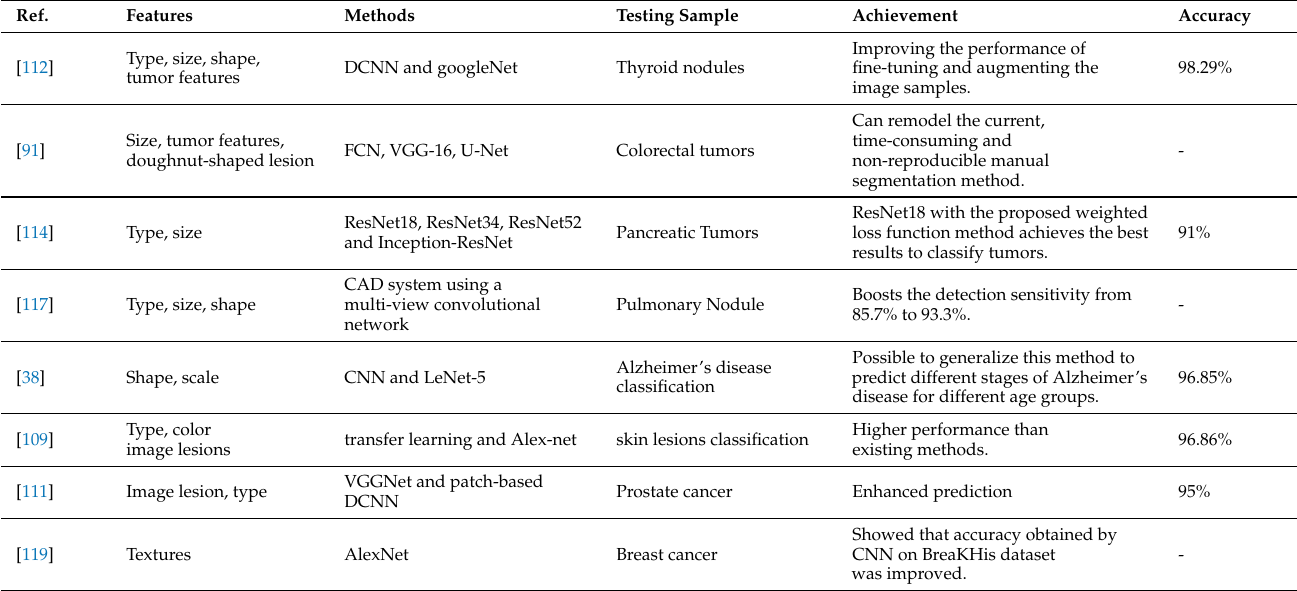
Table 7. CNN methods in medical